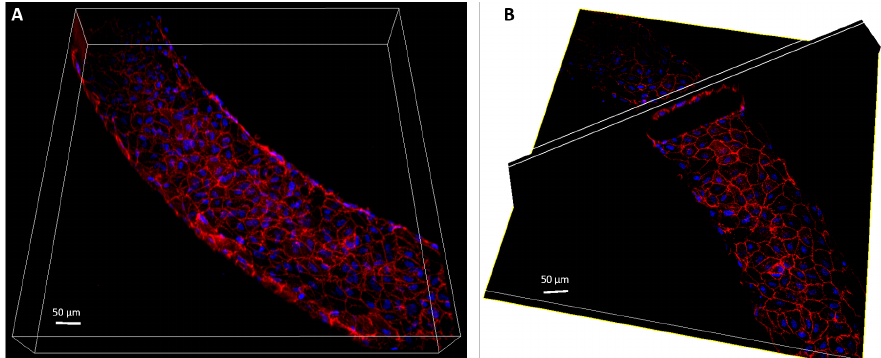
Figure 7. Three-dimensional reconstruction of the endothelium based on a confocal Z-stack acquisi- tion where VE-cadherin (red) and cell nuclei (blue) are stained. ( A ) Three-dimensional rendering of the vascular channel. ( B ) Three-dimensional orthogonal view of the endothelium to obtain a compound figure showing the horizontal section combined with a diagonal cross section.